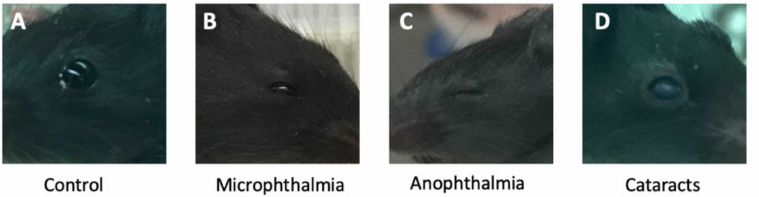
Figure 10. Cse1l CRISPR null heterozygotes may display ophthalmic abnormalities including mi- crophthalmia ( B ), anophthalmia ( C ), and early-onset cataracts ( D ). Wild-type shown in ( A